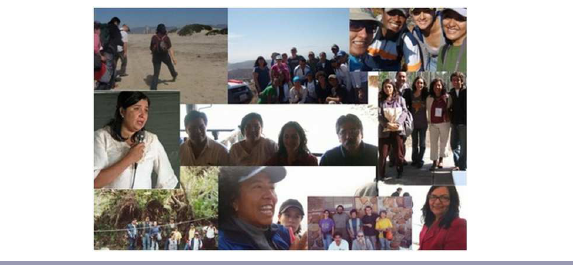
Fig. 1. MEZA teachers and students of several